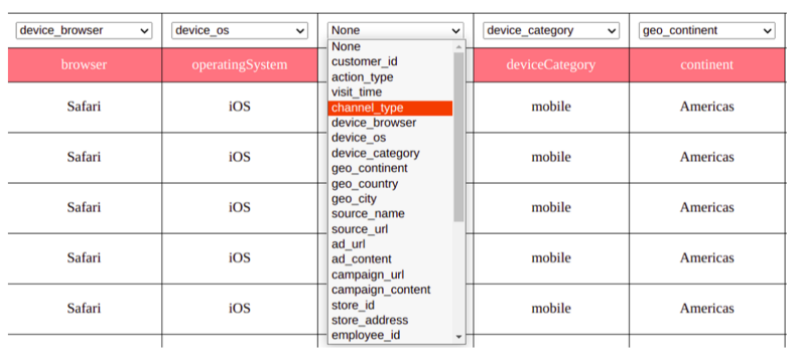
Fig. 4. CSV file importing and structure